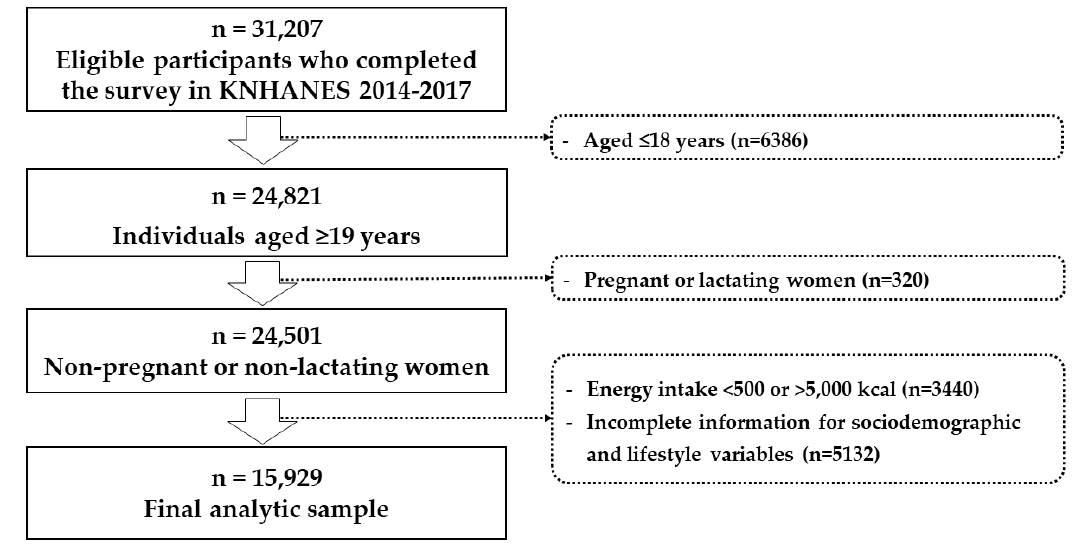
Figure 1. Flow chart of study participants.